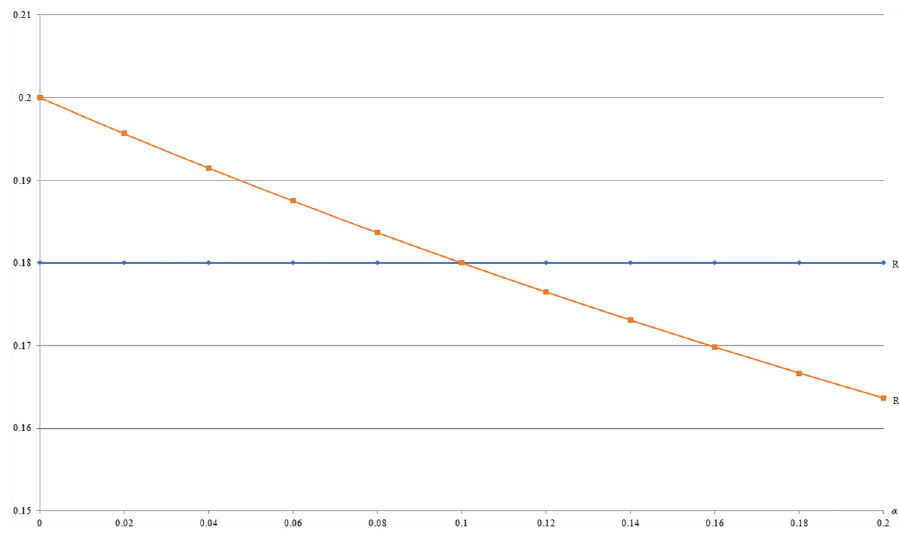
Fig 9. A comparison of revenues between IB and GB with respect to α